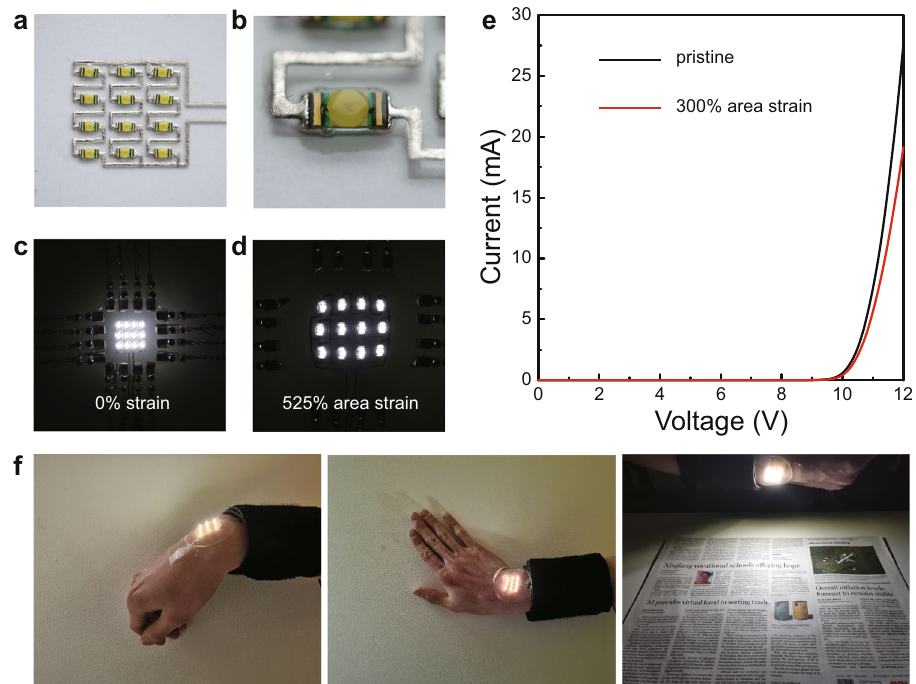
Fig. 5 Liquid metal-based stretchable integrated circuit systems. a Optical images of a stretchable integrated circuit in the form of an LED matrix. b Optical microscopy image revealing a representative LED chip mounted onto liquid metal interconnects. c , d Optical images of a luminous LED matrix at the relaxed state ( c ) and biaxially stretched state with 525% area strain ( d ). e Current – voltage curves of the LED matrix at 0 and 300% area strains. f Optical images of the LED matrix attached to the wrist as a wearable light source under wrist fl exion (left), and ulnar deviation (middle) gestures, which effectively lights up newspapers under dim lighting conditions